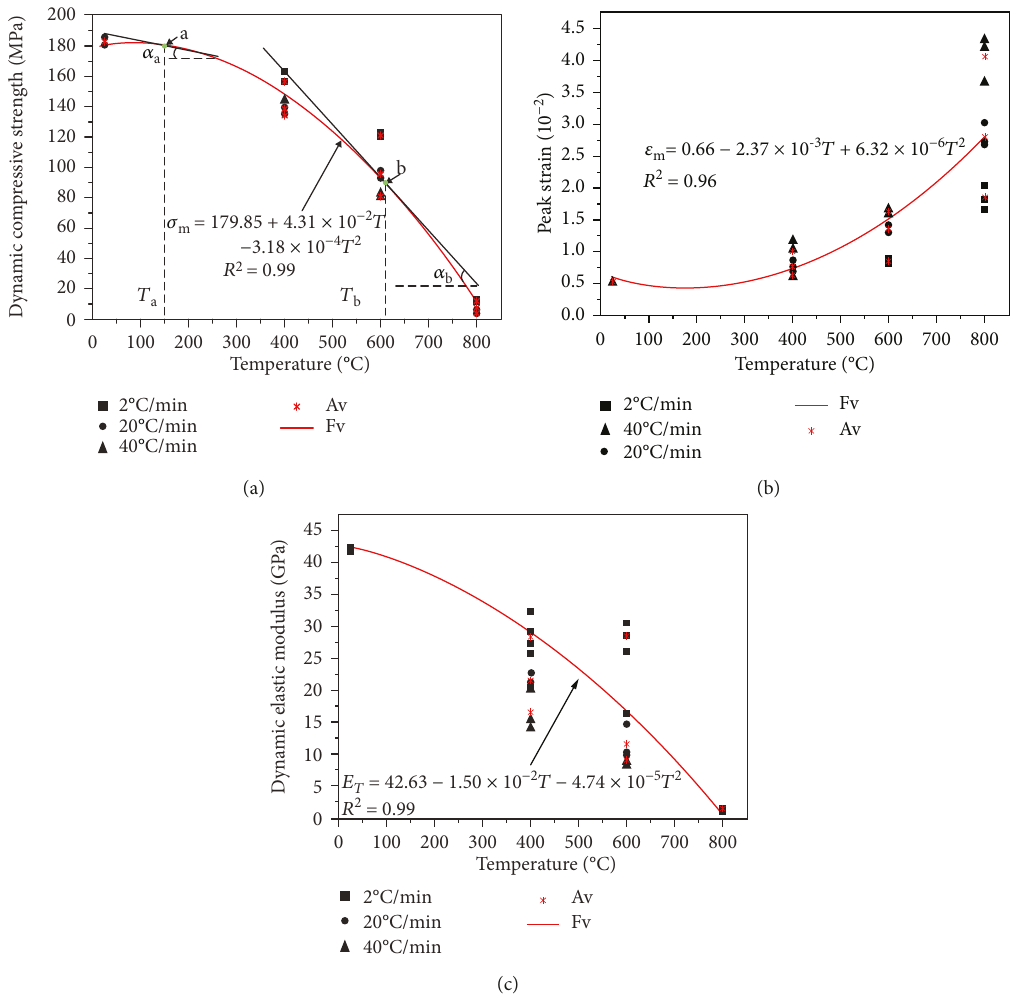
Figure 12: The correlation between dynamic compressive properties and temperature at various heating rates. (a) Correlation between the dynamic compressive strength and temperature at various heating rates; (b) correlation between peak strain and temperature at various heating rates; (c) correlation between the dynamic elastic modulus and temperature at various heating